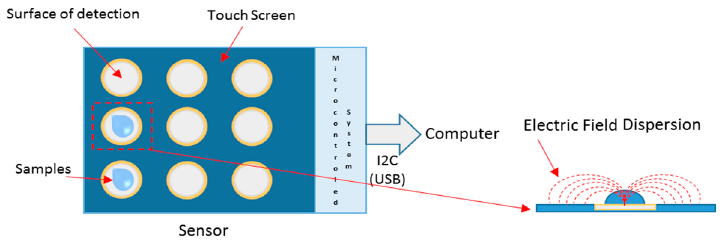
Figure 8. A detection system for a urinary infection.